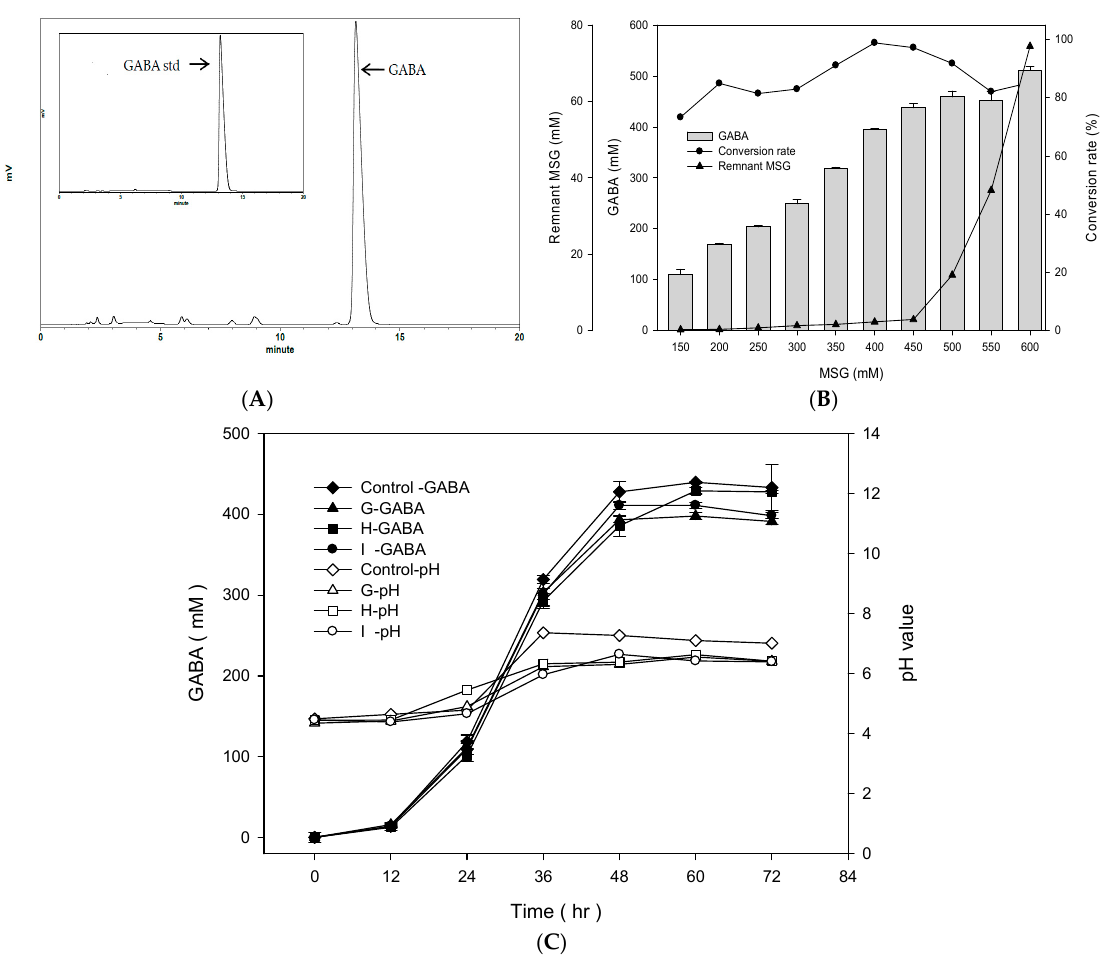
Figure 3. Comparison of the effect of different hydrogels on γ -aminobutyric acid (GABA) production ( A ) HPLC profiles of GABA produced by L. brevis RK03 grown in MRS broth with 450 mM monosodium glutamate (MSG) culture and GABA standard; ( B ) Effects of different concentrations of MSG on GABA production; ( C ) Effects of different types of hydrogels on GABA production and pH values.